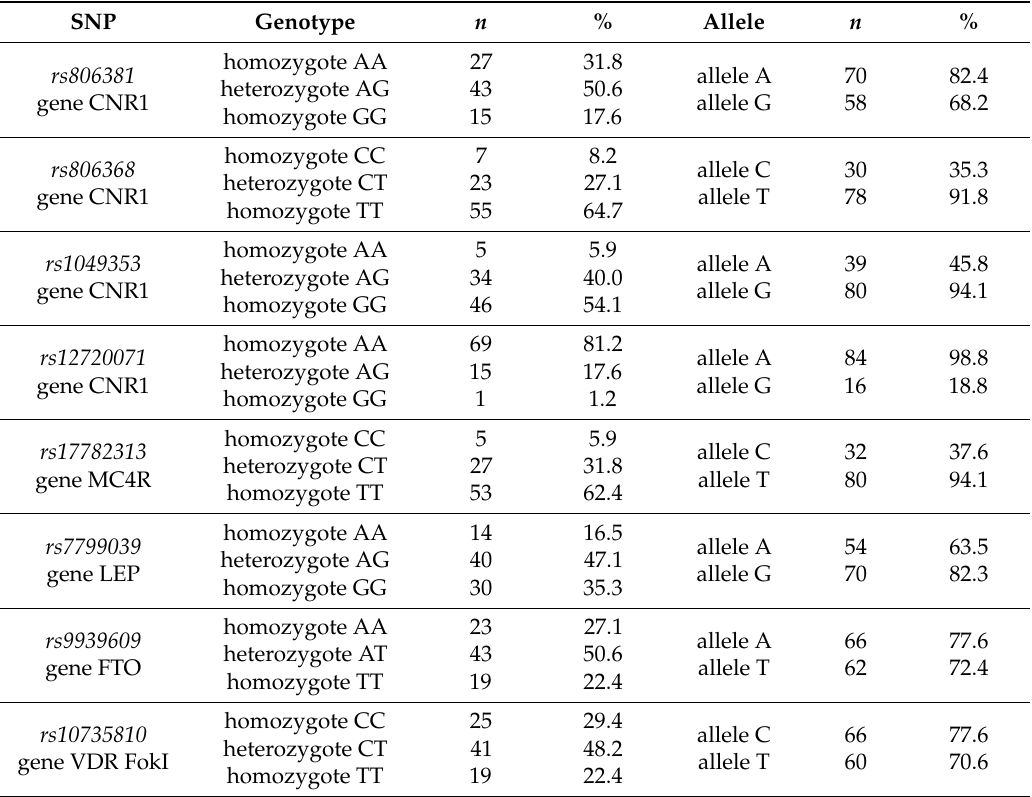
Table 4. Selected polymorphisms of genes CNR1, MC4R, LEP, FTO and VDR FokI in the study